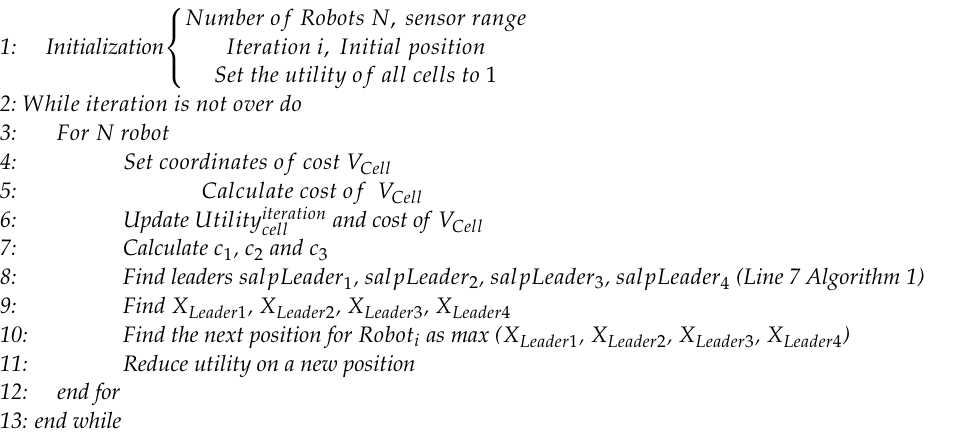
Algorithm 2 Coordinated Multi-Robot Exploration with Salp Swarm Algorithm